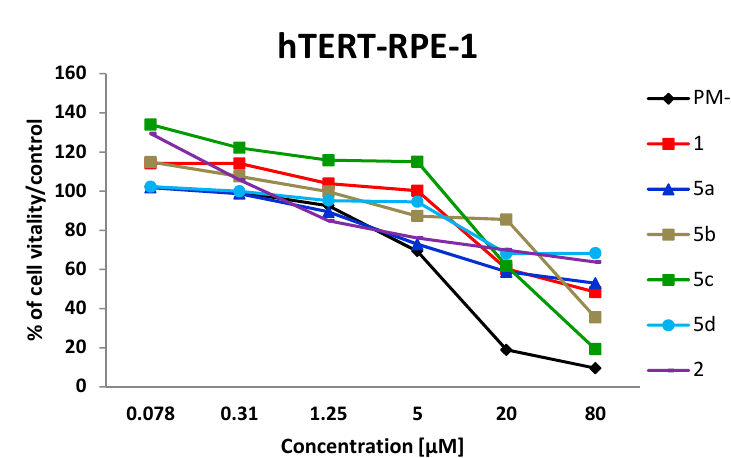
Figure 4. Cytotoxic curves of HCT116 ( A ), MCF 7 ( B ) cancer cells and normal epithelial cell line hTERT-RPE-1 ( C ) after challenge with increasing concentrations of PMs for 48 h. The morphological evaluation of HCT116 cells treated with sub-inhibitory concentration (0.1